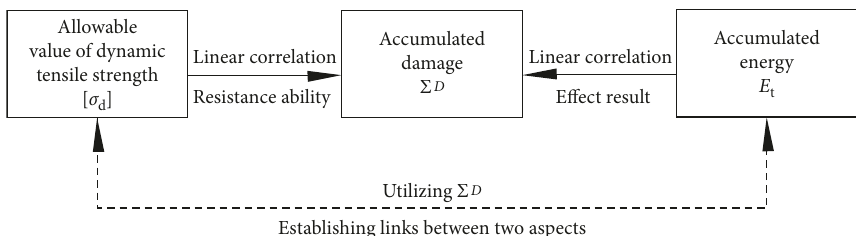
Figure 8: The association between the dynamic tensile strength and cumulative energy of each mold of the shaft lining.